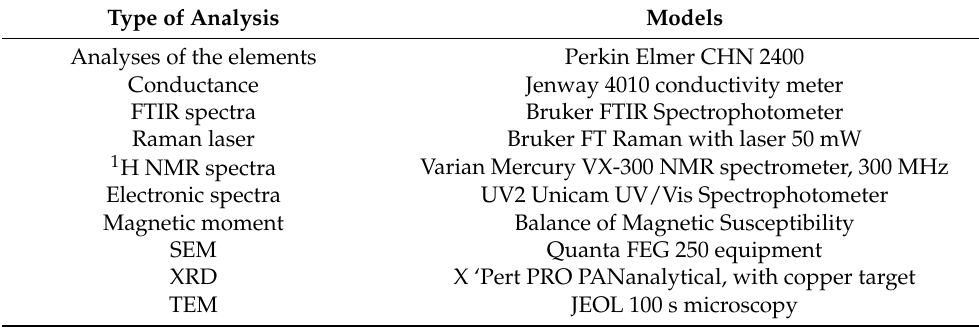
Table 1. Equipment used for measurements of data